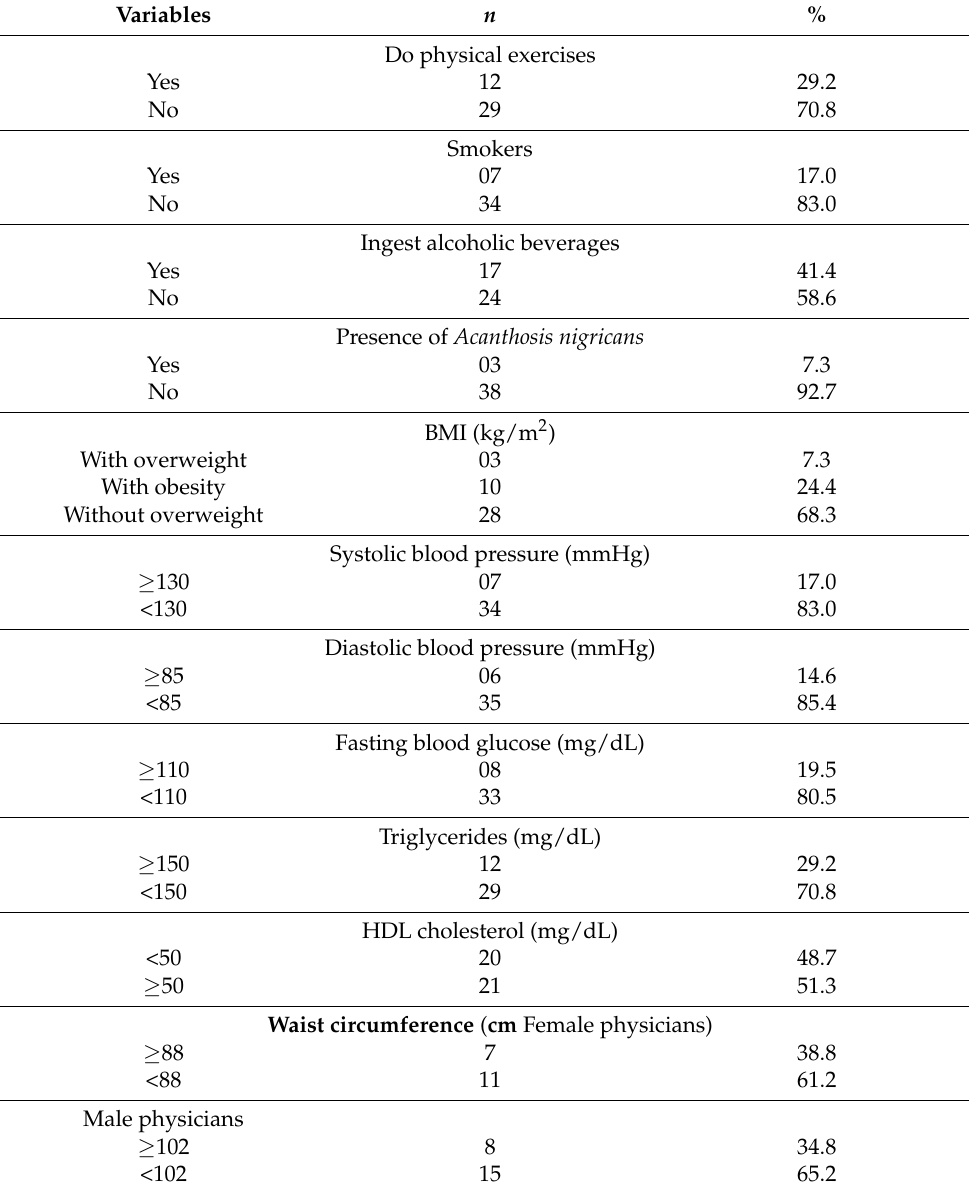
Table 2. Lifestyle characteristics and human biology of primary health care physicians. Mesoregion of Salvador, Bahia, Brazil, 2017 ( n =